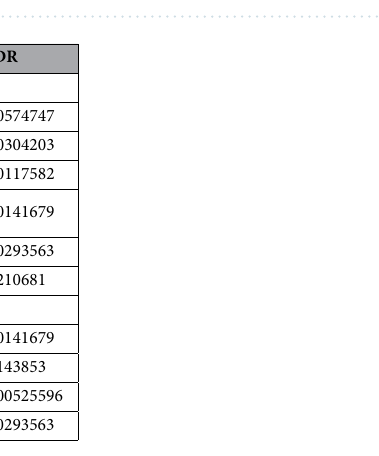
Table 4. List of the KEGG pathways found to be differentially expressed according to the RNAseq